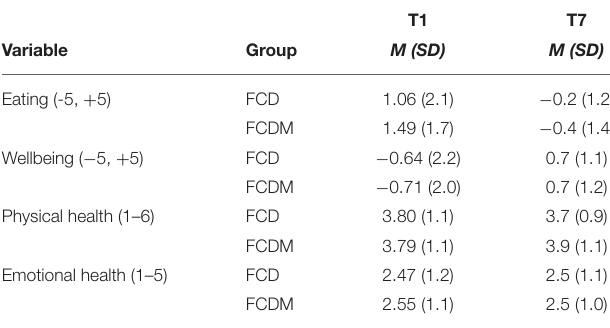
then detailed strategies they used to help manage this. TABLE 2 | Reported changes in eating, wellbeing, physical and emotional health at T1 and T7 for FCD and FCDM group participants.